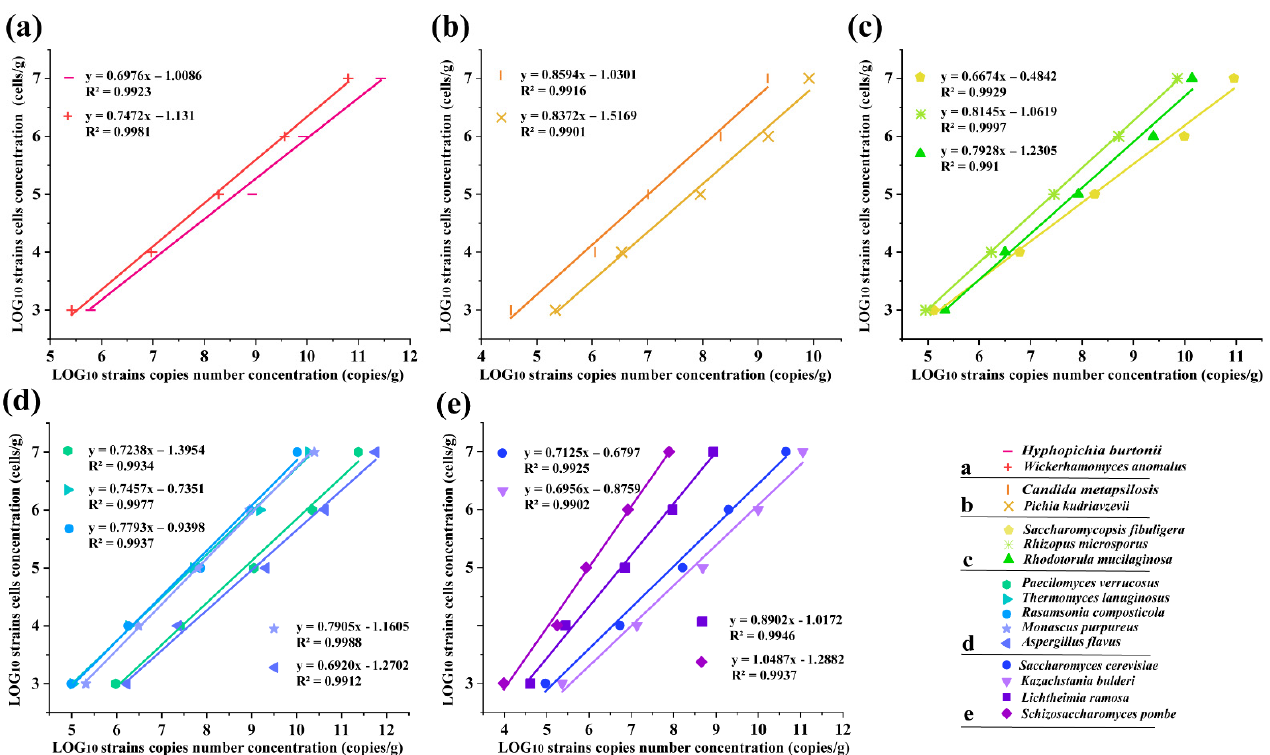
Figure 4. Standard curves of 16 core fungi. ( a ) Based on ISP I, used for the absolute quantification of Hyphopichia burtonii and Wickerhamomyces anomalus . ( b ) Based on ISP II, used for the absolute quantification of Candida metapsilosis and Pichia kudriavzevii . ( c ) Based on ISP III, used for the absolute quantification of Saccharomycopsis fibuligera , Rhizopus microspores , and Rhodotorula mucilaginosa . ( d ) Based on ISP IV, used for the absolute quantification of Paecilomyces verrucosus , Thermomyces lanuginosus , Rasamsonia composticola , Monascus purpureus , and Aspergillus flavus . ( e ) Based on ISP V, used for the absolute quantification of Saccharomyces cerevisiae , Kazachstania bulderi , Lichtheimia ramose , and Schizosaccharomyces pombe .